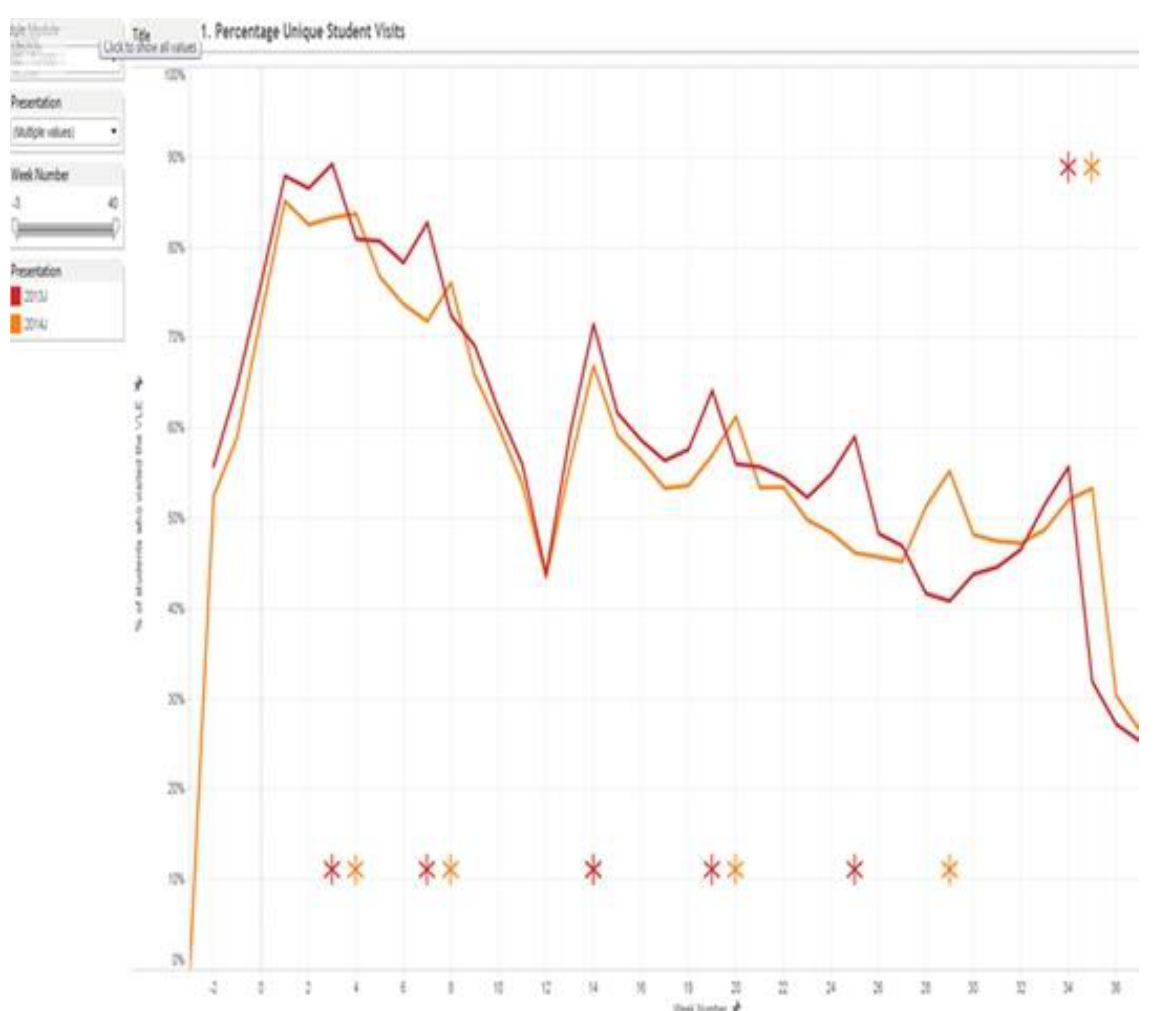
Figure 2 . VLE engagement in